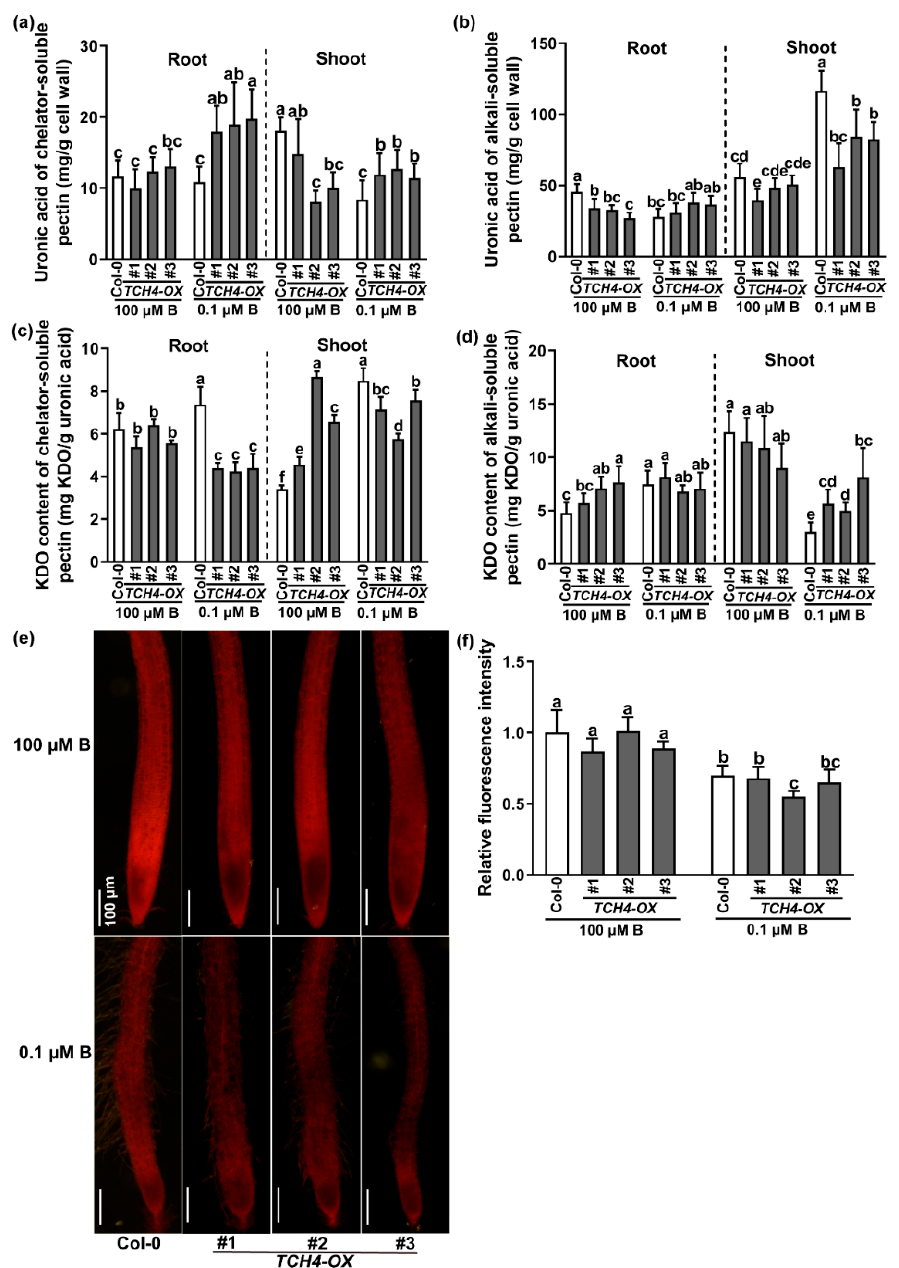
Figure 6. Differences in pectin content between Col-0 and TCH4 - OX plants. Plants were grown in solid media with normal B (100 µ M) for 8 d and then transferred to a nutrient solution containing 100 and 0.1 µ M B until bolting. ( a , b ) The uronic acid and ( c , d ) KDO content were measured in ( a , c ) chelator-soluble pectin and ( b , d ) alkali-soluble pectin. ( e ) Col-0 and TCH4 - OX plants grown